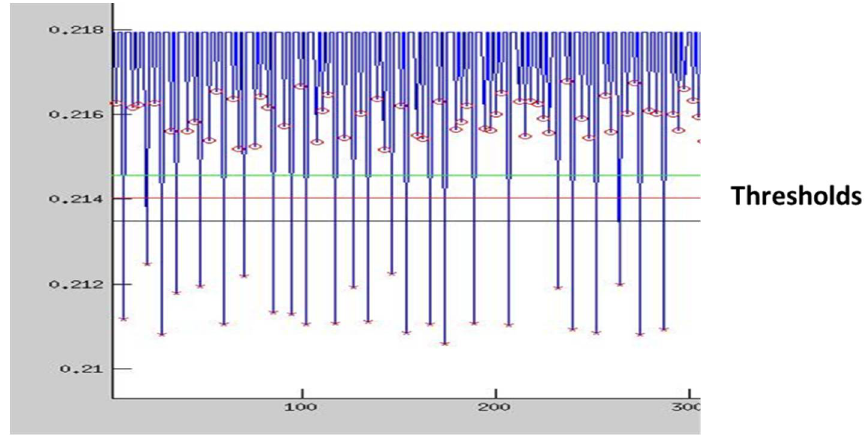
Figure 4. Automatic operation identification under Matlab.